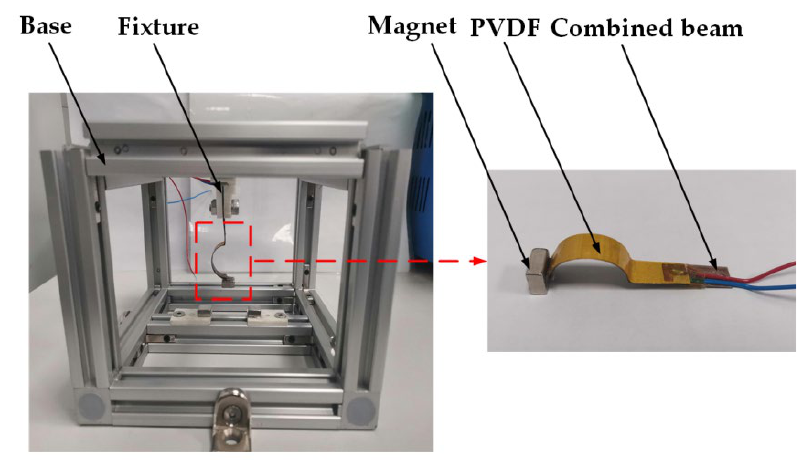
Figure 15. Experimental prototype of CTPEH.